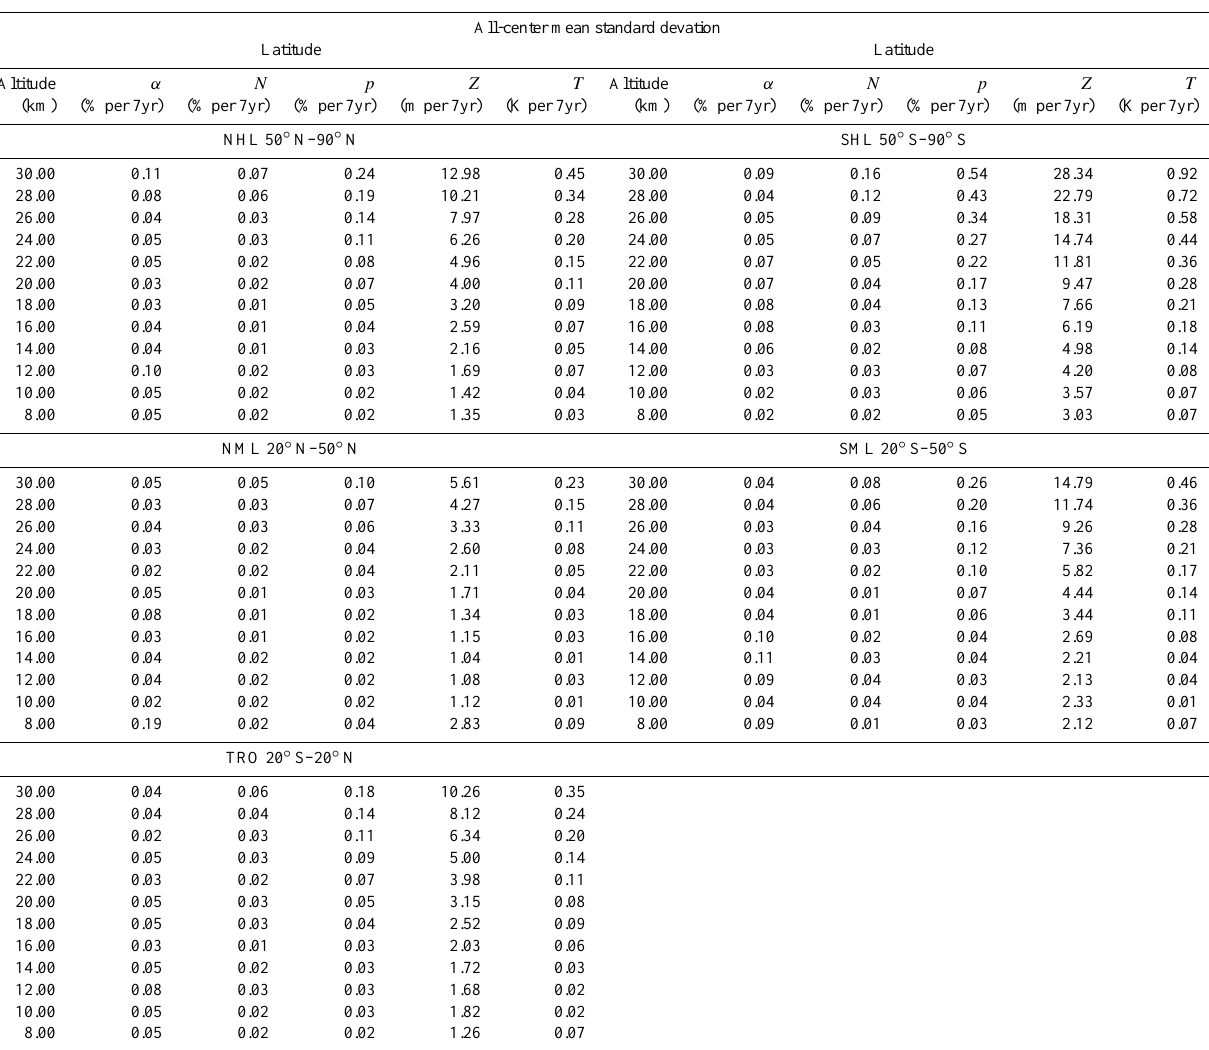
Table 3. Mean trend (all-center mean) and standard deviation of the trend for altitude levels from 8km to 30km at every other kilometer and for five latitude regions, for bending angle ( α) , refractivity ( N) , pressure ( p) , geopotential height ( Z) , and temperature ( T ) . The all-center mean includes DMI, EUM, GFZ, JPL, UCAR, WEGC for bending angle, and DMI, GFZ, JPL, UCAR, WEGC for refractivity to temperature. The estimated sampling error was subtracted for each parameter except for bending